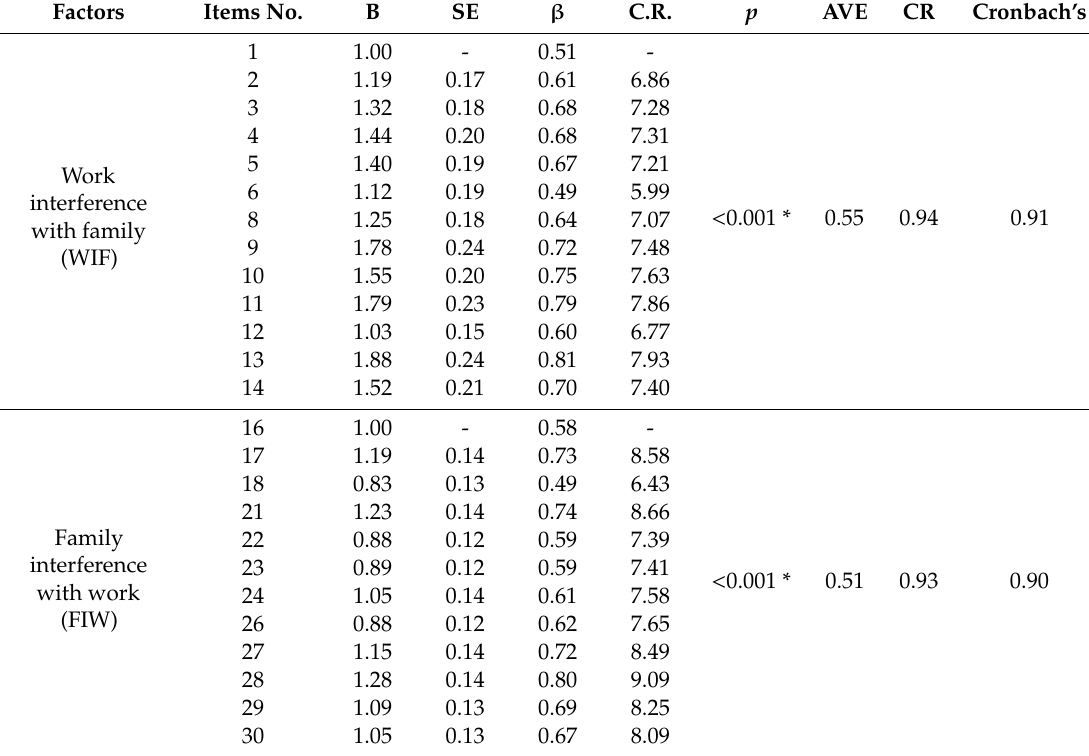
Table 2. Analysis of convergent validity of items.